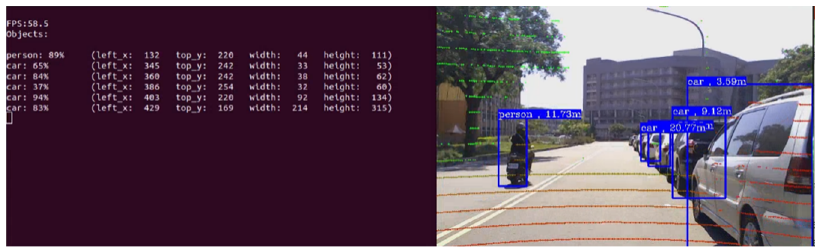
Figure 21. Instant dynamic vehicle environment testing.